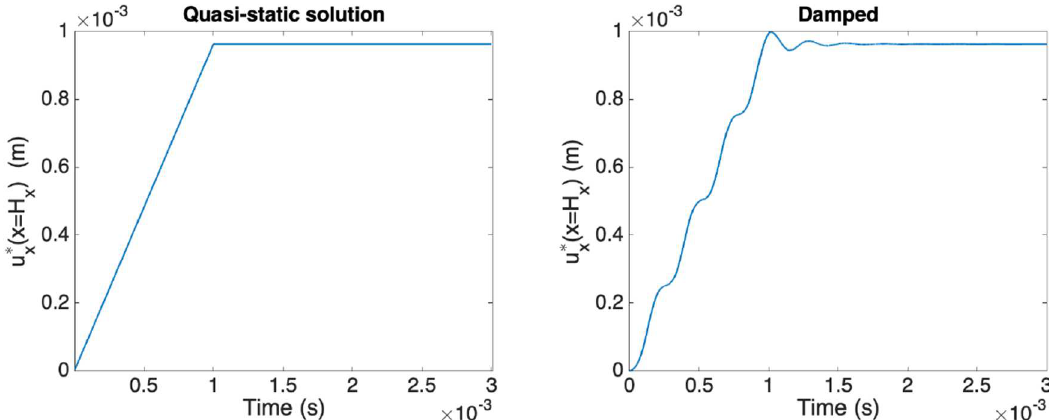
Fig. 11. Quasi-static (left) versus explicit damped (right) solutions.